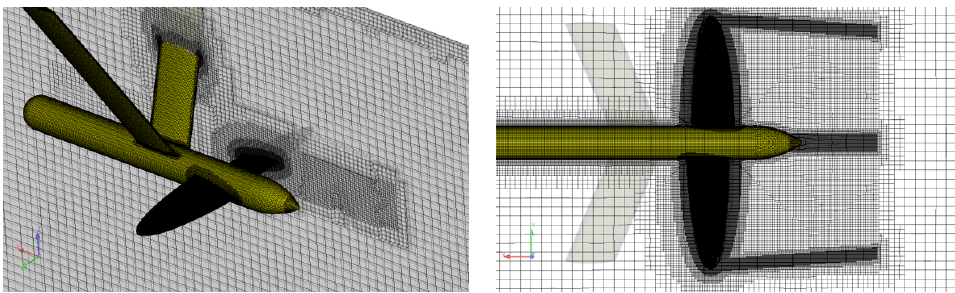
Figure 6. Computational domain for the CFD solution of the cavitator.